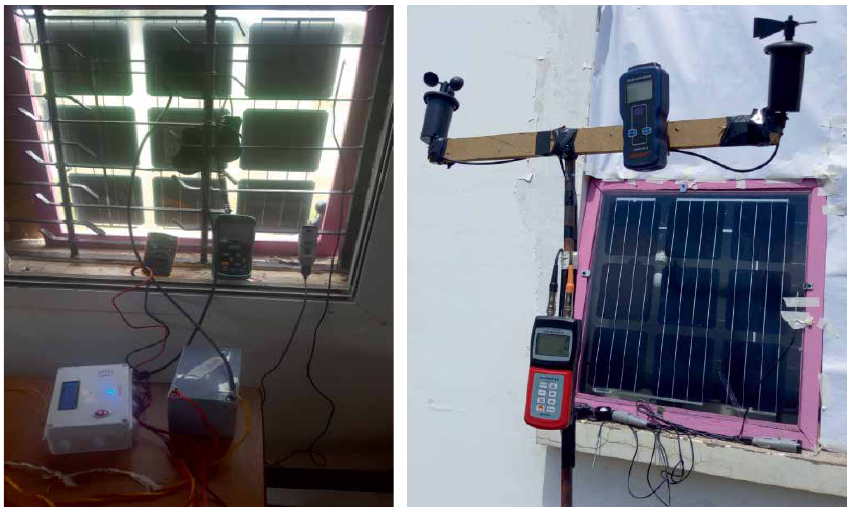
Figure 2: The inside and outside view of semi-transparent PV glazing on the window.